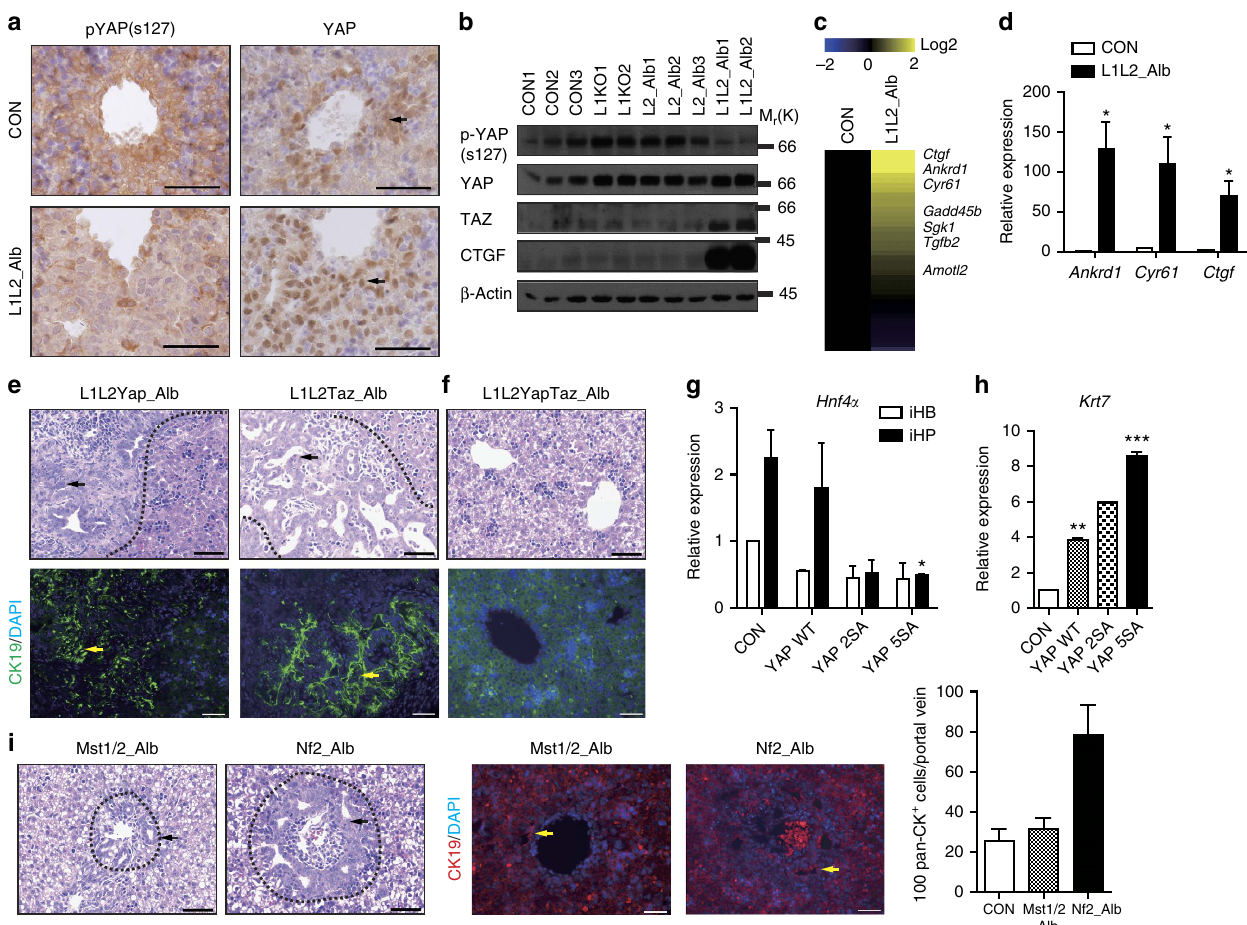
Figure 3 | Proper activity of YAP and TAZ are essential for ductal plate expansion. ( a ) Representative immunohistochemical staining results obtained with anti-phospho-YAP (S127) and anti-YAP in control and L1L2_Alb livers sampled at E16.5. Black arrows indicate positive signals. ( b ) Western blot analysis of whole livers obtained at E17.5 from embryos of the indicated genotypes. ( c , d ) Heat map ( c ) and qRT-PCR ( d ) of YAP target genes, reflecting microarray data obtained with mRNAs from control and L1L2_Alb P1 livers. ( e , f ) Representative images of haematoxylin and eosin (H&E) staining (upper) and immunofluorescence staining (lower) with anti-CK19 and diamidino-2-phenylindole (DAPI) of Lats1 (cid:2) / (cid:2) ; Lats2 fl/fl ; Yap fl/fl ; Alb-Cre (L1L2Yap_Alb), Lats1 (cid:2) / (cid:2) ; Lats2 fl/fl ; Taz fl/fl ; Alb-Cre (L1LTaz_Alb) ( e ) and Lats1 (cid:2) / (cid:2) ; Lats2 fl/fl ; Yap fl/fl ; Taz fl/fl ; Alb-Cre (L1L2YapTaz_Alb) ( f ) livers at P1. Black dotted lines indicate boundary between ductal plates and non-ductal plates. Black arrows indicate ductal plate cells. Yellow arrows indicate CK19-positive signal. ( g ) Relative mRNA expression levels of Hnf4 a in control, YAP WT, -2SA and -5SA over-expressing iHPs. ( h ) Quantification of cytokeratin 7 mRNA expression in control, YAP WT, -2SA and -5SA over-expressing iBECs. n ¼ 2. ( i ) H&E staining (left) and immunofluorescene staining (right) with anti-CK19 and DAPI of Mst1 and -2 double-knockout livers and Nf2 knockout livers at P1. The graph shows quantification of pan-CK-positive cells per portal triad. Black arrows indicate ductal plate cells, and the dotted lines indicate ductal plates. Yellow arrows indicate positive signals to CK19. Scale bars, 50 m m; the data are presented as means ± s.e.m.; n ¼ 3, * P o 0.05 and ** P o 0.01 (Student’s t